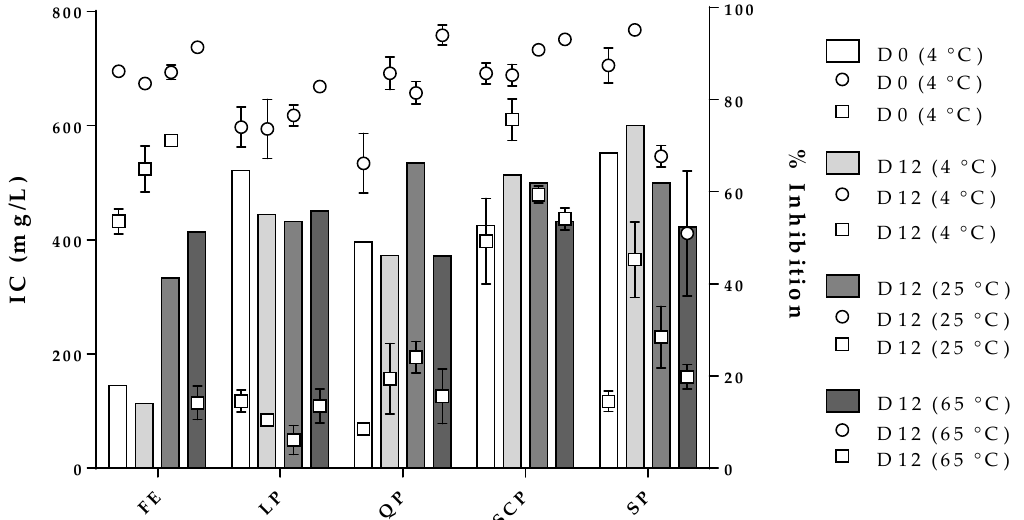
Figure 7. Effect of storage conditions on the free and encapsulated extracts and their influence on the inhibitory concentration (IC, bars, y-axis) against B. cereus ( , z-axis) and S. aureus ( , z-axis). FE: free extract, LP: lentil protein, QP: quinoa protein, SCP: sodium caseinate, SP: soy protein, D0: zero- day storage, D12: twelve-day storage.